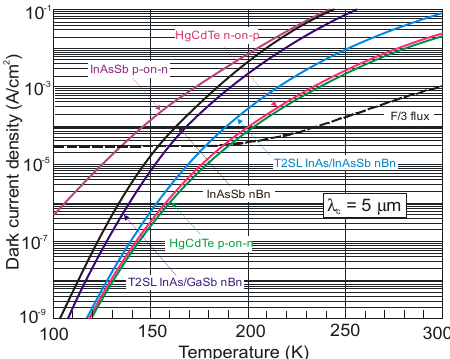
Figure 50. Dark current density versus temperature for InAsSb p-on-n photodiode and nBn detector, T2SL nBn detectors, and HgCdTe photodiodes with λ cut-off = 5 μ m.